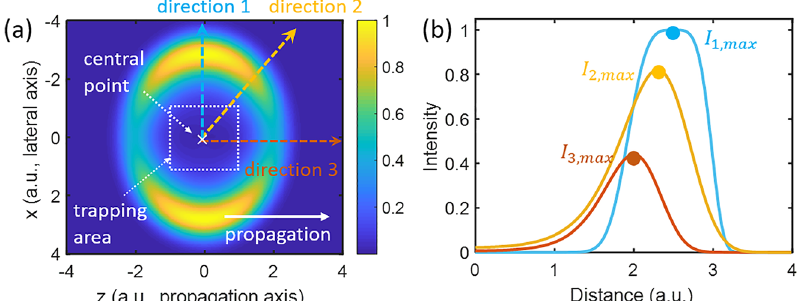
Figure 1: (a) Schematic intensity profile of an optical bottle-beam trap in the x – z